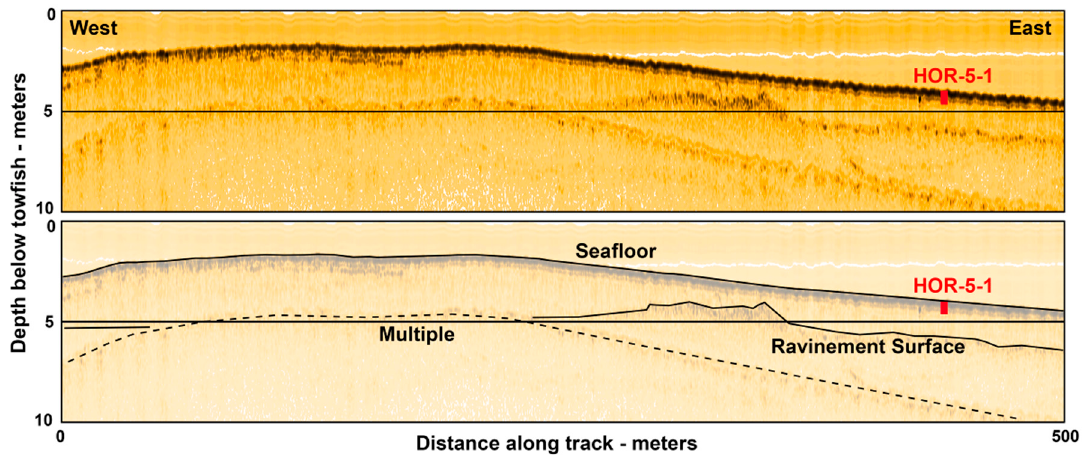
Figure 4. Seismic reflection profile from the northwest corner of the HoR running roughly west to east across a portion of the ebb-tidal delta. Red lines show the location of core HoR-5-1. See Figure 1 for the location of the survey line. Vertical exaggeration is 10×.